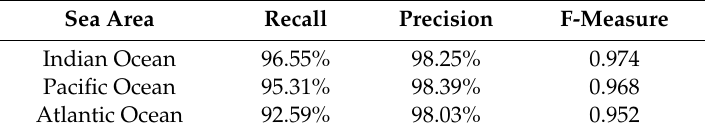
Figure 8. The eddies detected by Ocean Eddy Detecion Net (OEDNet) in di ff erent sea areas. ( a ) Indian Ocean, ( b ) Pacific Ocean, and ( c ) Atlantic Ocean. Color map and contours (black lines) represent the geostrophic velocity speed [m / s] (Equation (1)) and sea level anomaly [cm], respectively. Table 3. The detection e ff ect of the model on several di ff erent sea